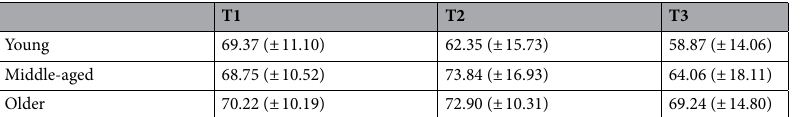
Table 2. Subjective cognitive rating in age-groups across time. Means and standard deviations in parentheses are reported. Subjective cognition was assessed by 16 items. Participants were asked to indicate how well they coped with the requested skills. They used a visual analog scale ranging from 0 (very poorly) to 100 (very well). The requested skills were derived from dimensions of episodic and implicit memory, executive functions, attention and working memory. The overall mean served as a proxy of general subjective cognitive performance.